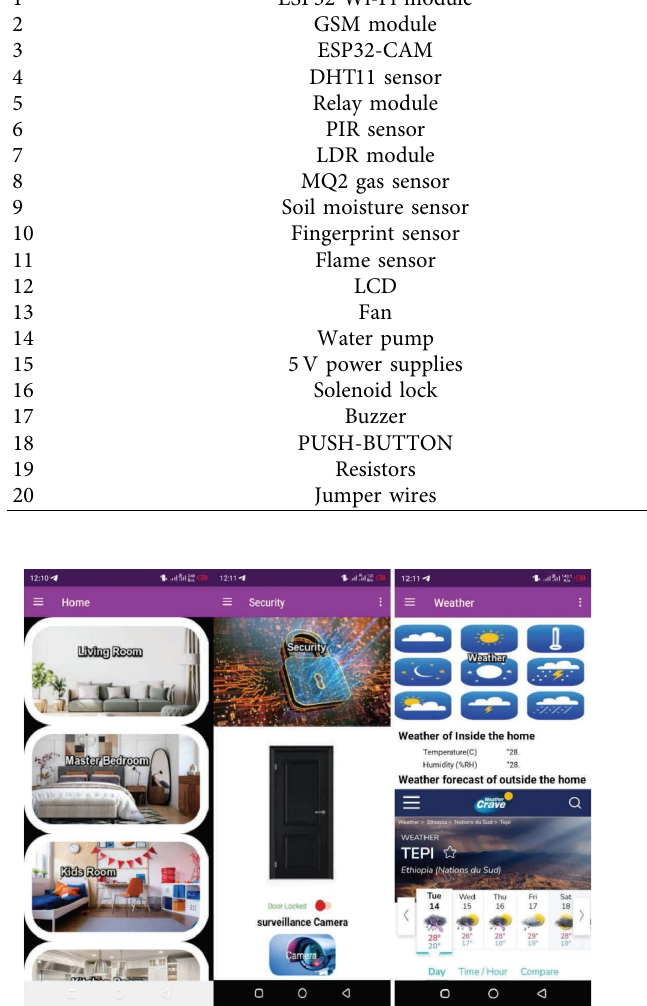
Figure 7: Overall view of the android application.